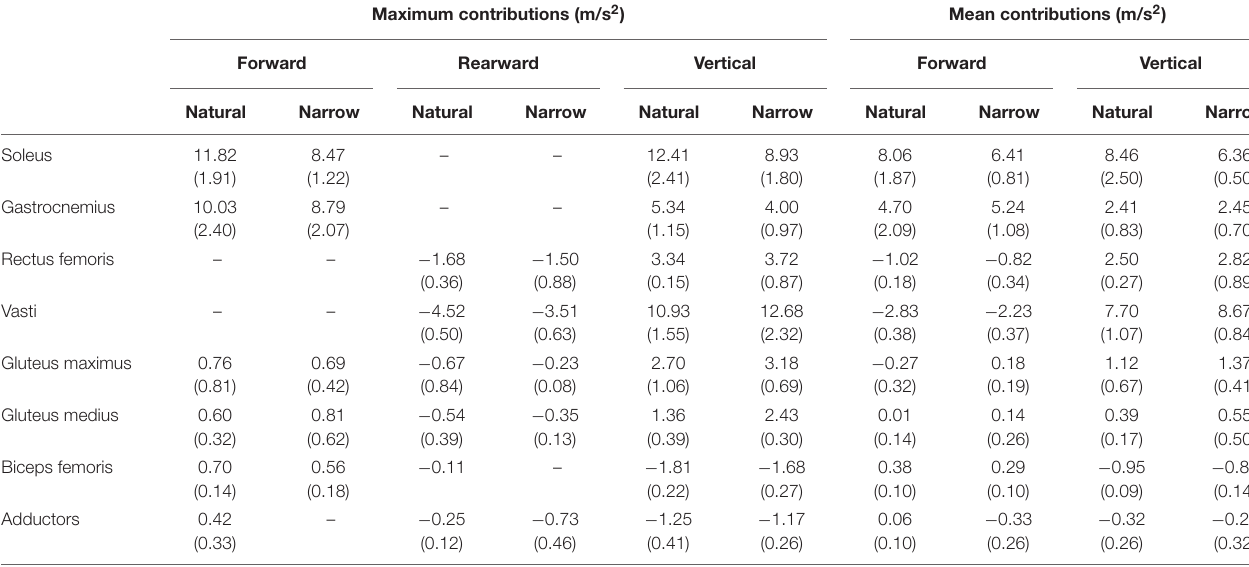
TABLE 1 | Comparison of the maximum and mean muscle contributions to forward and vertical COM accelerations in the natural and narrow trials. Maximum contributions (m/s 2 ) Mean contributions (m/s 2 )